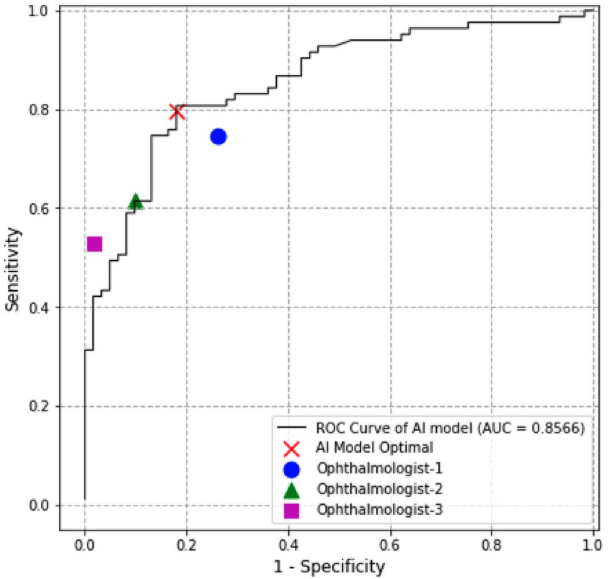
Figure 5. Receiver operating characteristic curve using OCT diagnosis as standard diagnosis. Operation points of manual diagnosis were illustrated on the graph, in order to compare the performance between ophthalmologists and AI model. AUC areas under the curve.